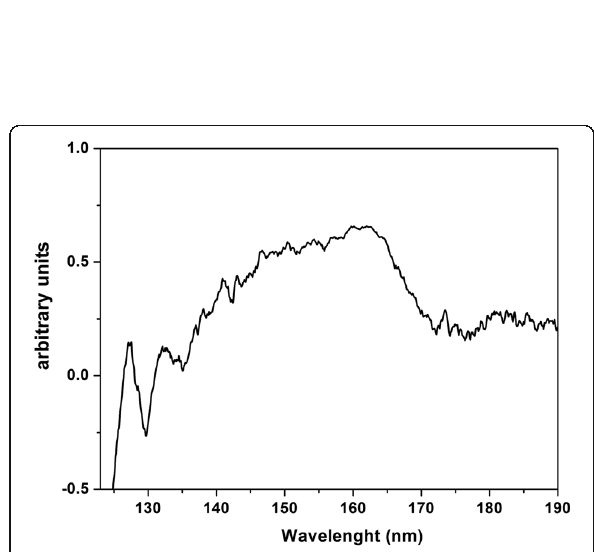
Fig. 8 VUV transmission spectrum of PrF 3 NPs in water suspensions deposited on the dried CaF 2 substrate. The spectrum indicates water attachment and trapping within PrF 3